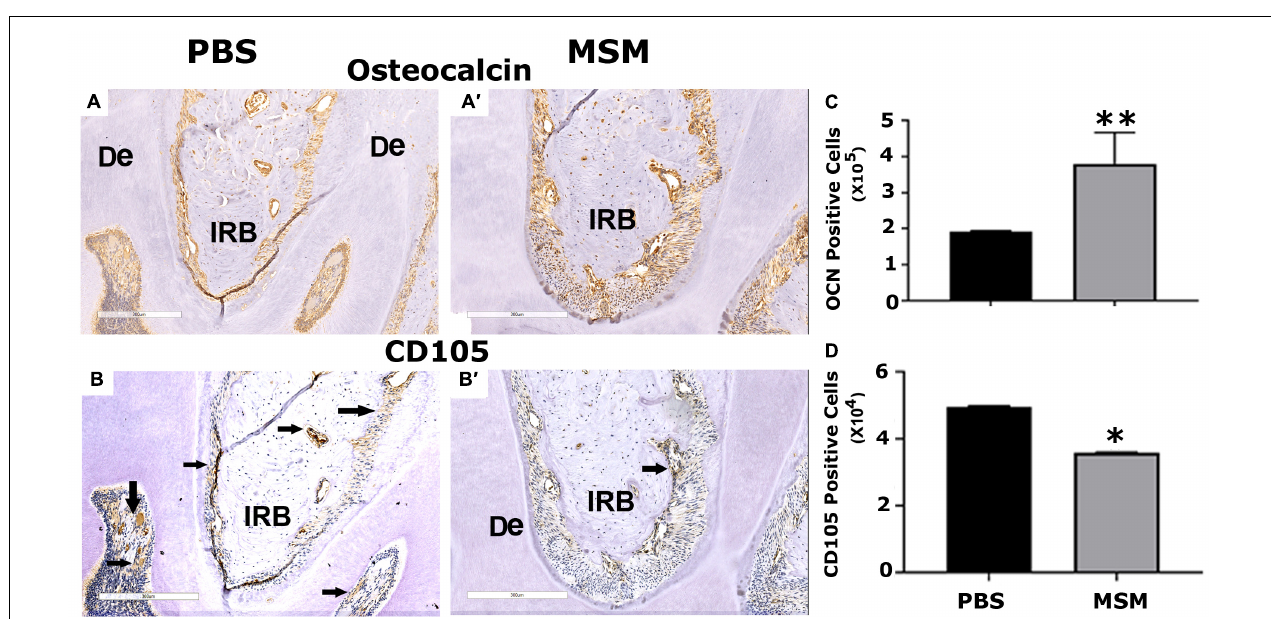
FIGURE 6 | Immunohistochemistry analysis in mandible sections. Bone sections were stained with an antibody against (A,B) OCN or (A (cid:48) ,B (cid:48) ) CD105. Inter-radicular bone and dentine are abbreviated as IRB and De; arrows point to cells stained for CD105 (A (cid:48) ,B (cid:48) ) . Quantification of (C) OCN- and (D) CD105-positive cells was performed using Fiji (ImageJ) software, and the results are shown as the mean ± SEM of six mice per injection. A standard Student’s t -test was used to analyze p -values. ∗∗ p < 0.01 and ∗ p < 0.05. Scale bar: 300 µ m.